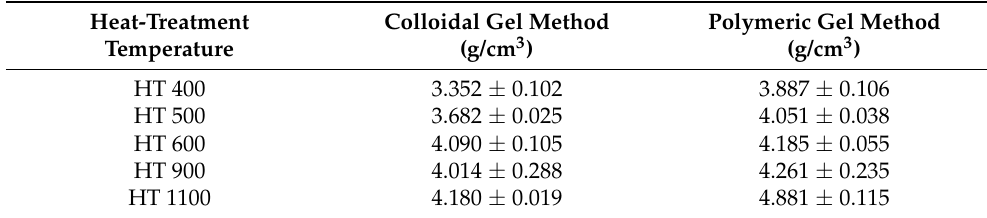
Table 2. Measured densities of the samples prepared via the colloidal gel and polymeric gel methods.